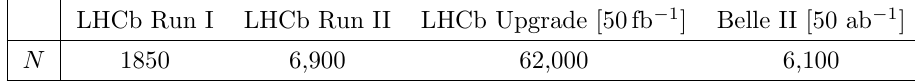
Table 1 . Number of produced pseudo events per toy